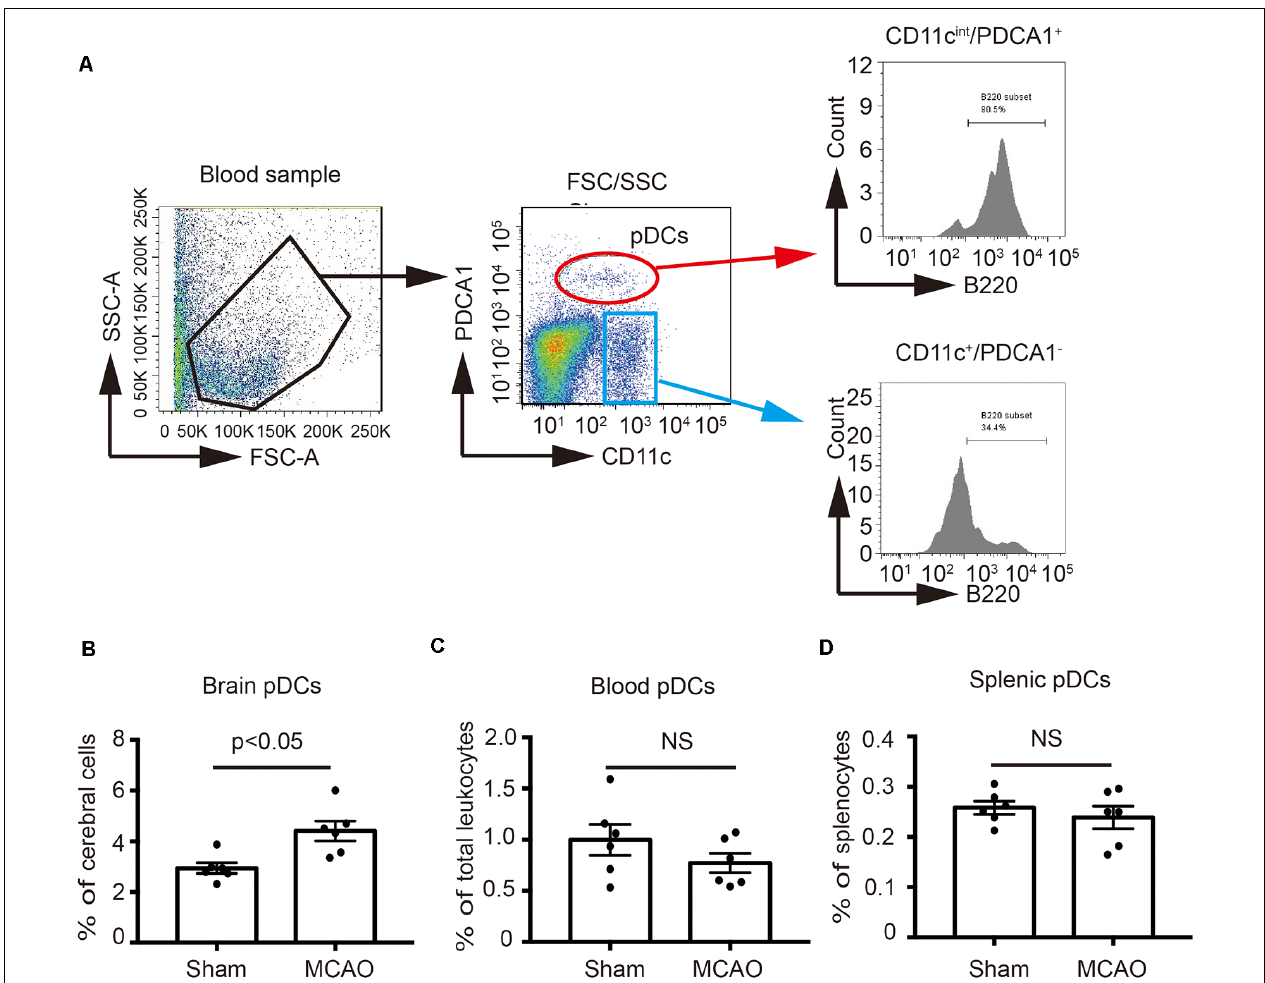
FIGURE 1 | Middle cerebral artery occlusion (MCAO) increased the number of plasmacytoid dendritic cells (pDCs) in the brain. Brain ischemia was induced by 45 min MCAO. Sham-operated animals underwent surgical exposure of the right middle cerebral artery without occlusion. (A) The gating strategy to identify the pDCs in the blood. The pDCs population (CD11c int PDCA1 + B220 + ) in the (B) brain, (C) spleen and (D) blood was analyzed with Flow cytometry. Data are expressed as means ± SEM for n = 6 mice per group. The scatter plots represent independent samples. NS: no